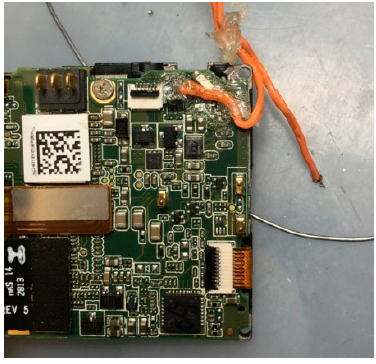
Figure 12 . Modification of the GoPro buttons to PWM-controlled relay switch. Figure 12. Modification of the GoPro buttons to PWM-controlled relay